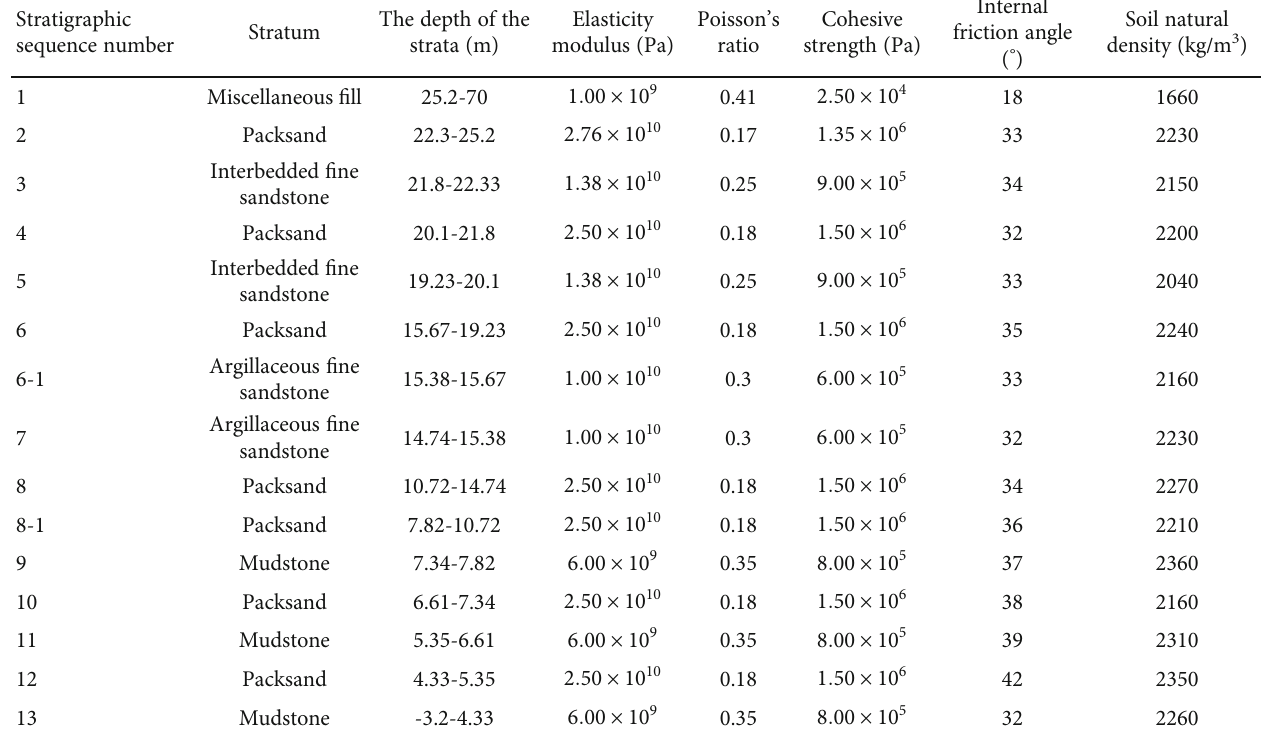
Table 1: Mechanical parameters of surrounding rock.